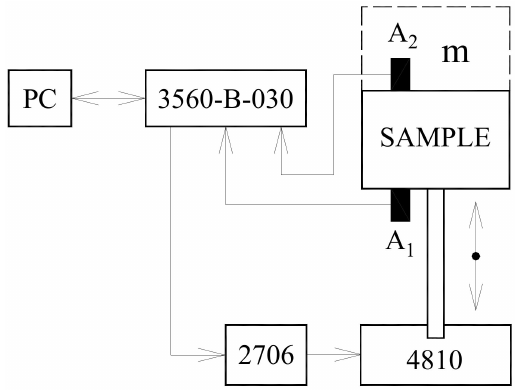
Figure 1. Schematic diagram of the measuring device.